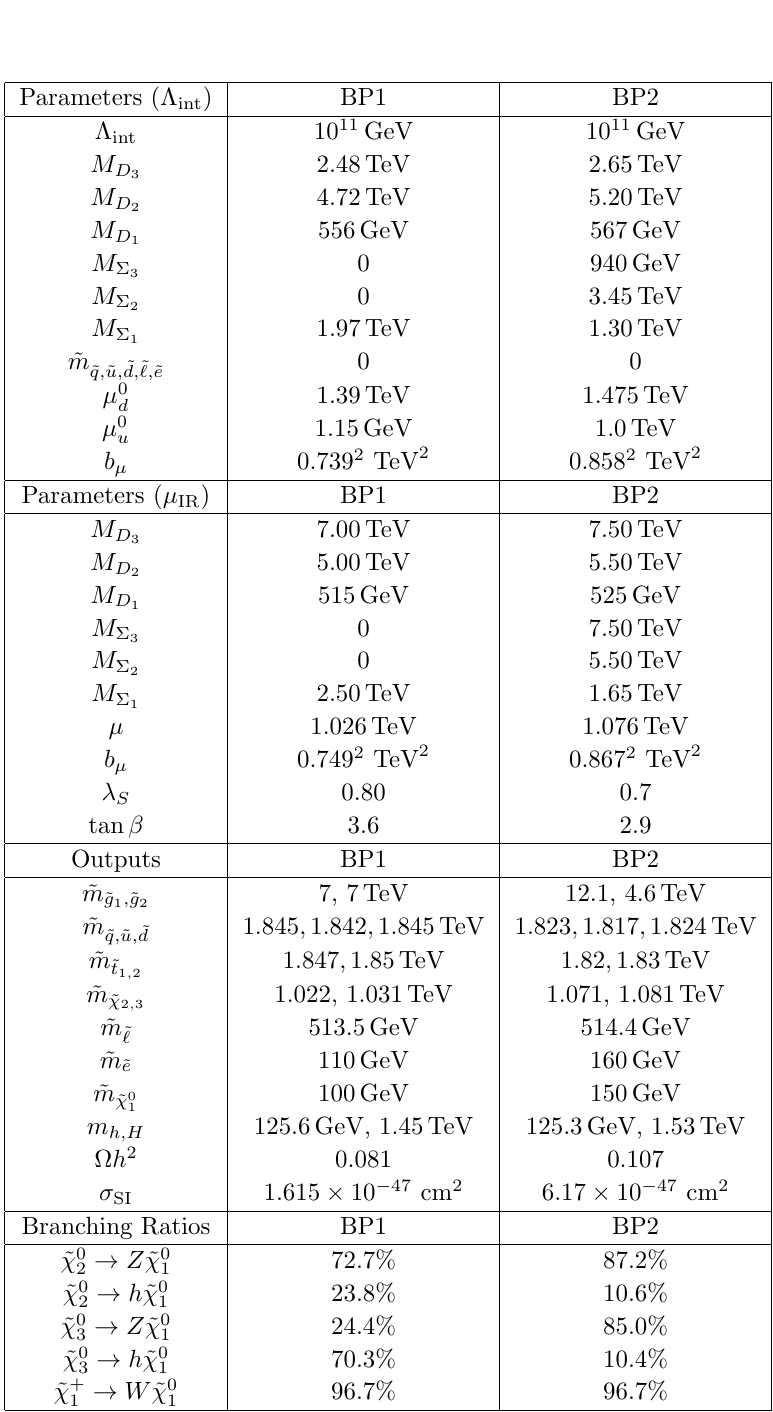
Table 2 . Benchmark points for GSS scenarios with the two di(cid:11)erent values of (cid:21) S . Points satisfy the Higgs mass and DM relic density and direct detection constraints. The DM direct detection limit for a 100 GeV WIMP is around 9 10 (cid:0) 47 cm 2 (cid:2)